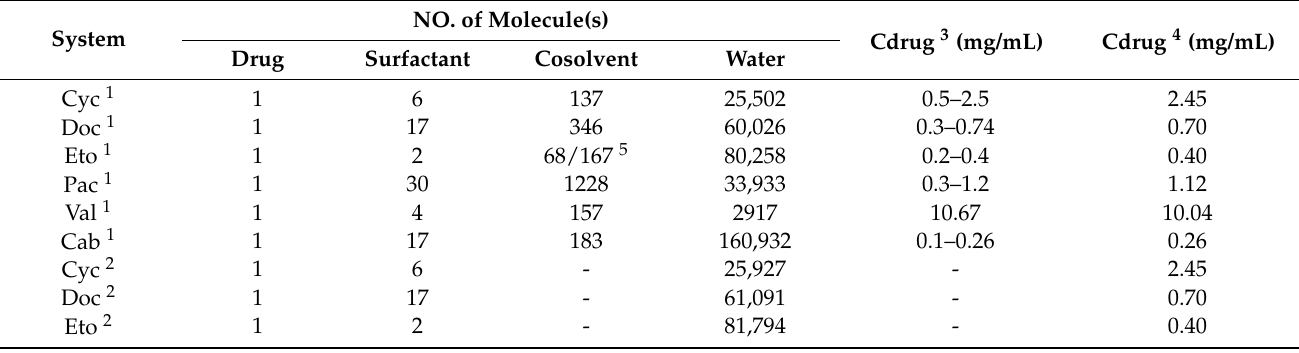
Figure 1. Chemical structures of drugs and excipients. Table 2. The details of the simulated